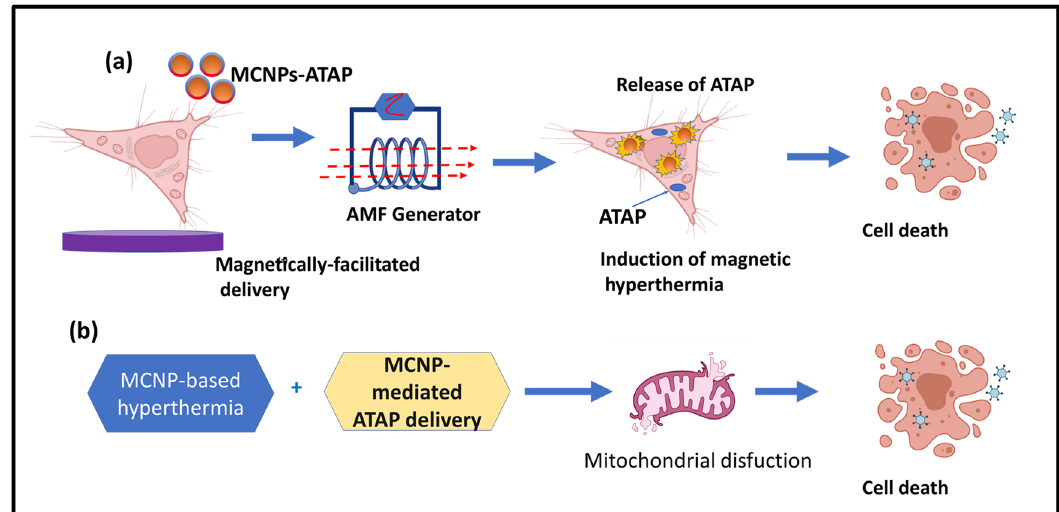
Figure 8: Schematic representation of temperature - responsive systems.